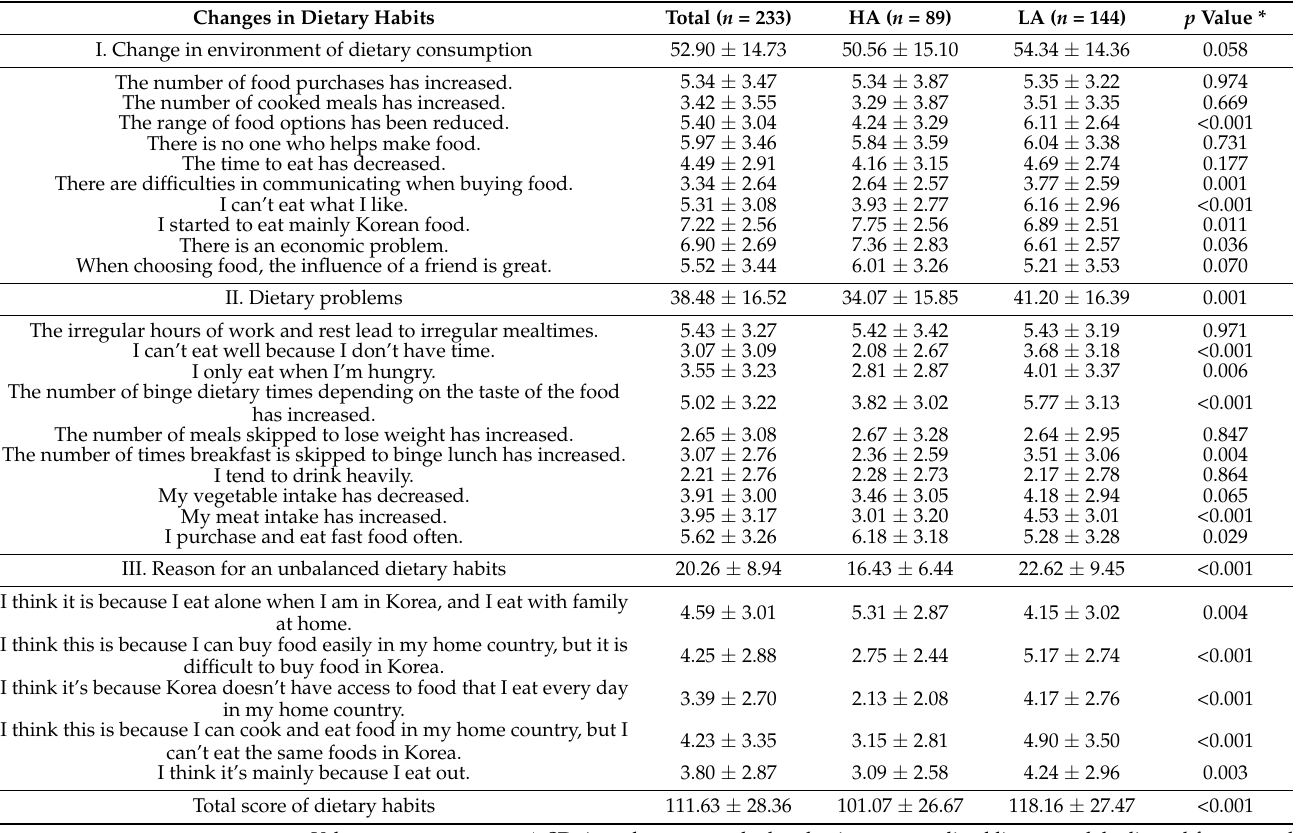
Table 2. Changes in dietary habits after studying abroad according to acculturative